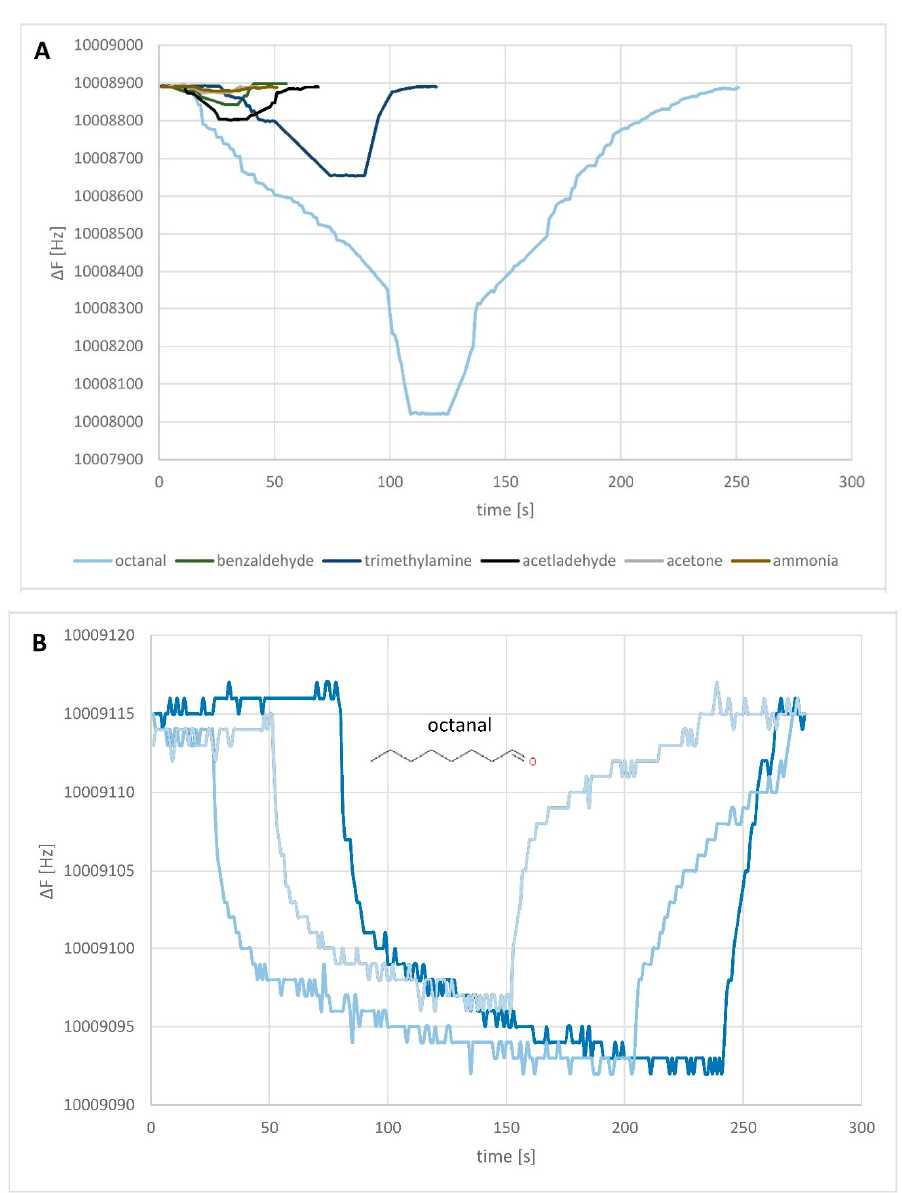
Figure 2. ( A ) Resonant frequency responses of the OBPP4-based biosensor to different tested compounds in high concentrations (octanal, 1435 ppm; benzaldehyde, 2198 ppm; trimethylamine, 1594 ppm; acetaldehyde, 4007 ppm; acetone, 3028 ppm; ammonia, 9619 ppm v / v ) in the gas phase. ( B ) OBPP4-based biosensor responses for the lowest concentration of octanal in gas phase in three repetitions (37.5 ppm v / v ).